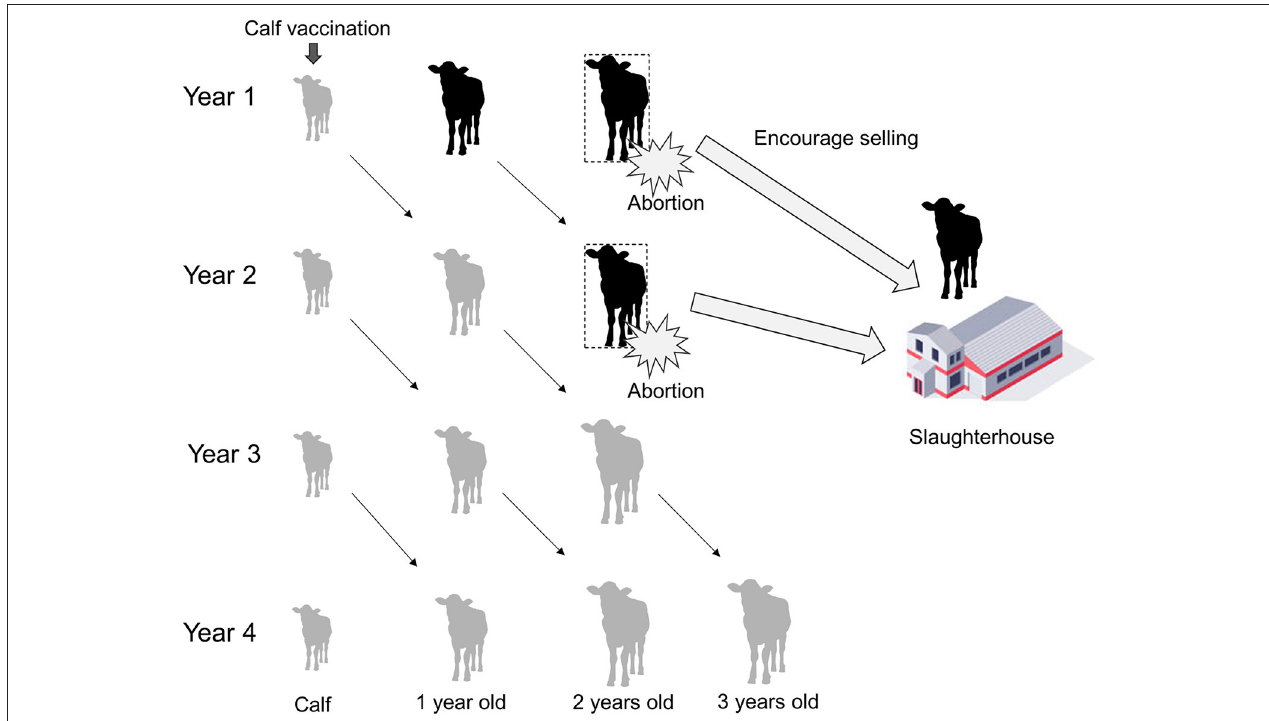
FIGURE 2 | Schematic diagram showing a community-based brucellosis control plan involving selling cows with experience of abortion for slaughter and calf vaccination paid for by the farmers themselves. By following the plan, the proportion of immunized cows increases and that of brucellosis-infected cows decreases over